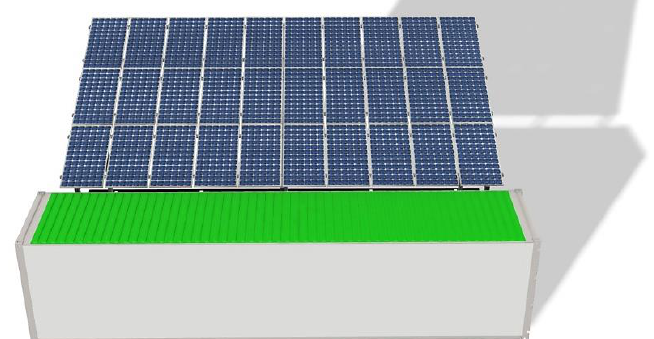
Figure 22. Photovoltaic solar generation system: 12.5 kW/13.2 kWp and 30 × 440 W peak .